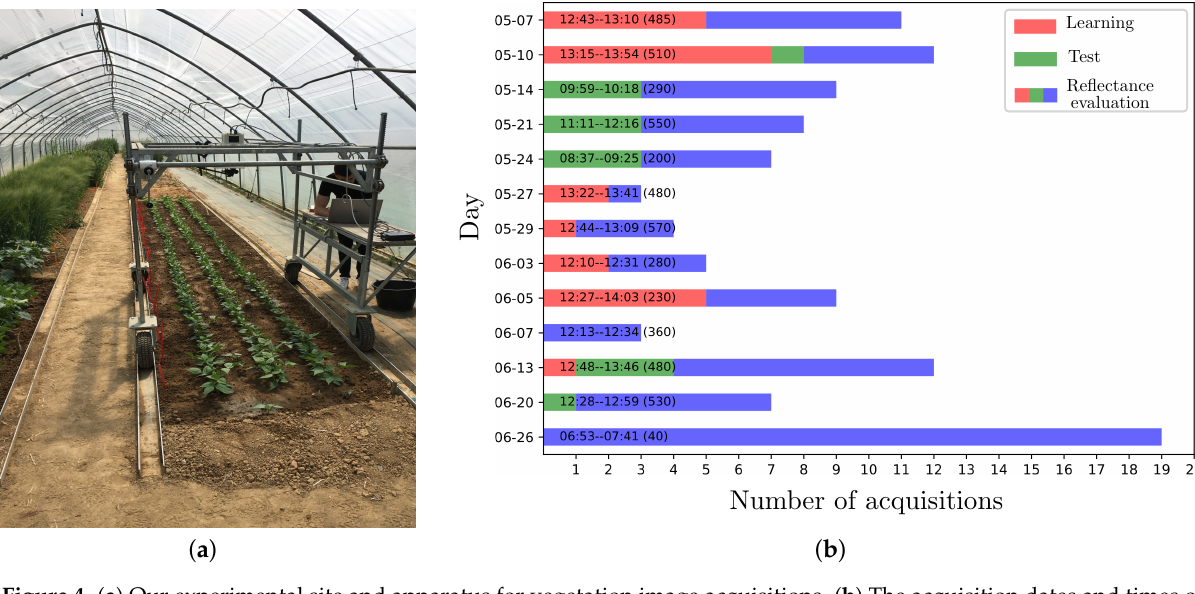
Figure 4. ( a ) Our experimental site and apparatus for vegetation image acquisitions. ( b ) The acquisition dates and times of the 109 images that were provided by our 2019 acquisition campaign. The text along each bar gives the acquisition time range and a coarse estimation of global solar irradiance (W m − 2 ) at the median acquisition time in parentheses [22]. The · images used to assess supervised beet (crop) and weed detection/identification (see Section 6) are shown in red and green, other images in blue. All of the images are used to assess reflectance estimation quality. Series are stacked for readability and their order is not meaningful in regards to any acquisition time